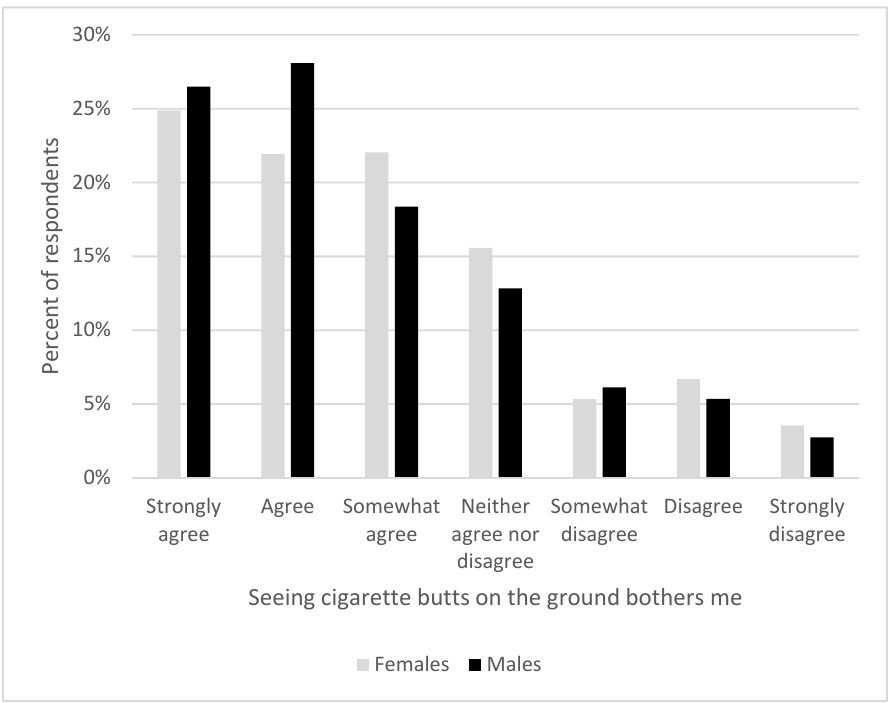
Figure 7. Responses, by gender, to the statement, “Seeing cigarette butts on the ground bothers me”. ( n = 7532).